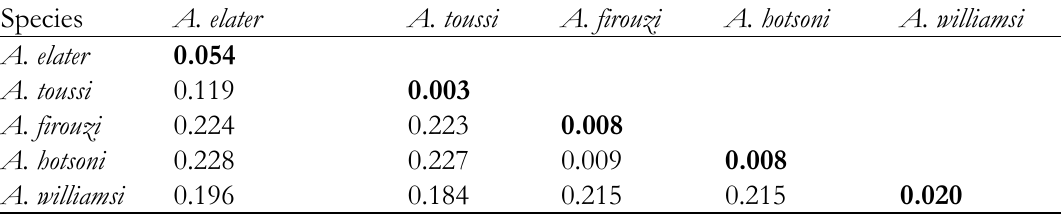
F IG . 1. Scatter plot of a stepwise discriminant analysis, based on all morphometric variables of Allactaga. T ABLE 5. Kimura-2-parameter genetic distance interspecies and intraspecies (Bold